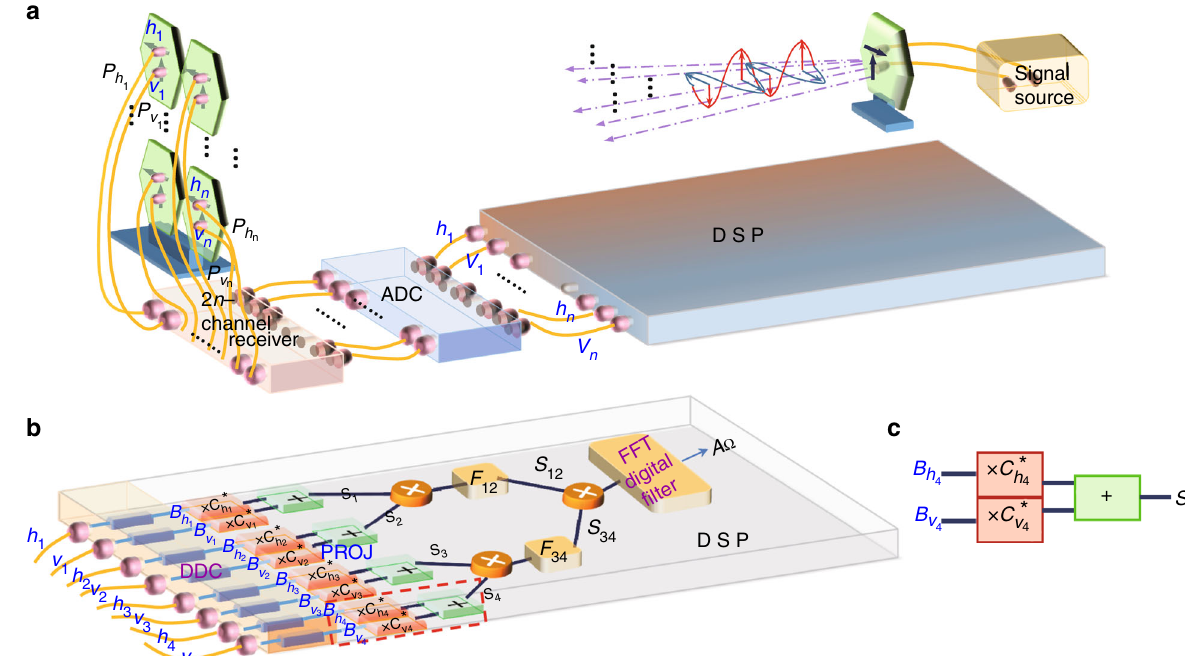
Fig. 3 The experimental set-up to construct and characterize the CMESs as the analogy of quantum MESs. a The overall designed classical microwave signal processing system, including transmitting and receiving dual-polarized antennas, a 2 n -channel receiver array, an analog-to-digital converter (ADC) and a programmable DSP module. b An example of the work fl ow to construct the 4-cebit analog ψ cl { h 1 , … , v 4 } fed into the DSP are arranged by a digital down-converter (DDC) to have their own frequencies as planned. After a measuring process through the PROJ part followed by several mixing and fi ltering processes for multiplex signals, the desired signal component A Ω is selected by the FFT-based digital fi lter, and we collect its complex amplitude as described in Eq. (5). The red dashed box highlights a unit of the PROJ part as depicted in c , including two multiplications and an adder, which can be tuned conveniently to perform desired projective measurement